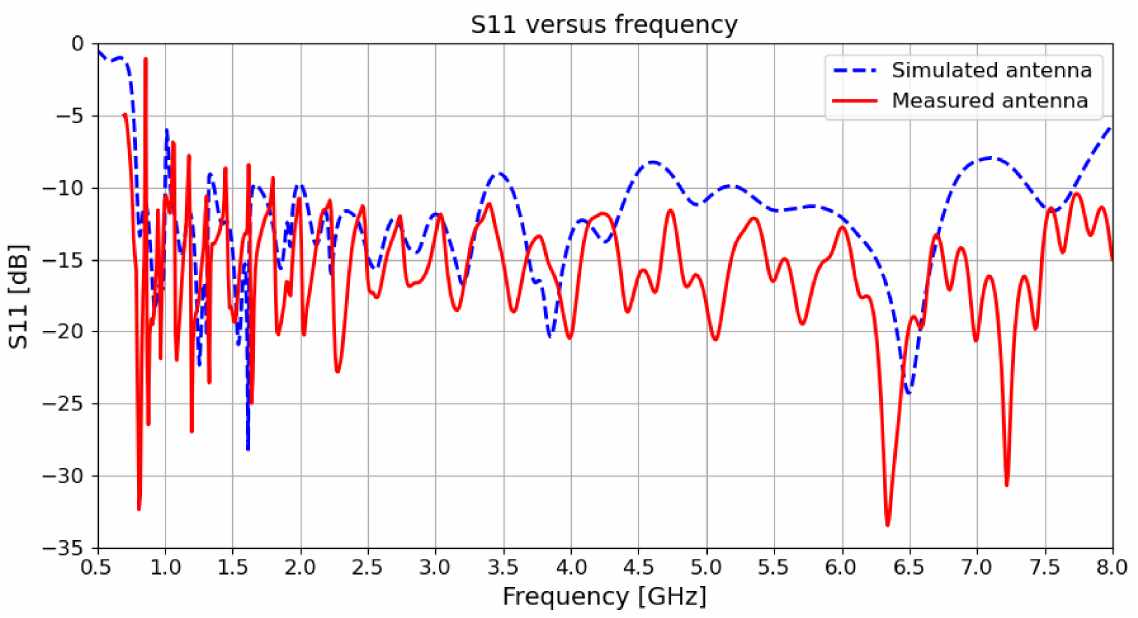
Figure 12. Comparison of the simulated and measured S11 of the conventional PLPDA design.